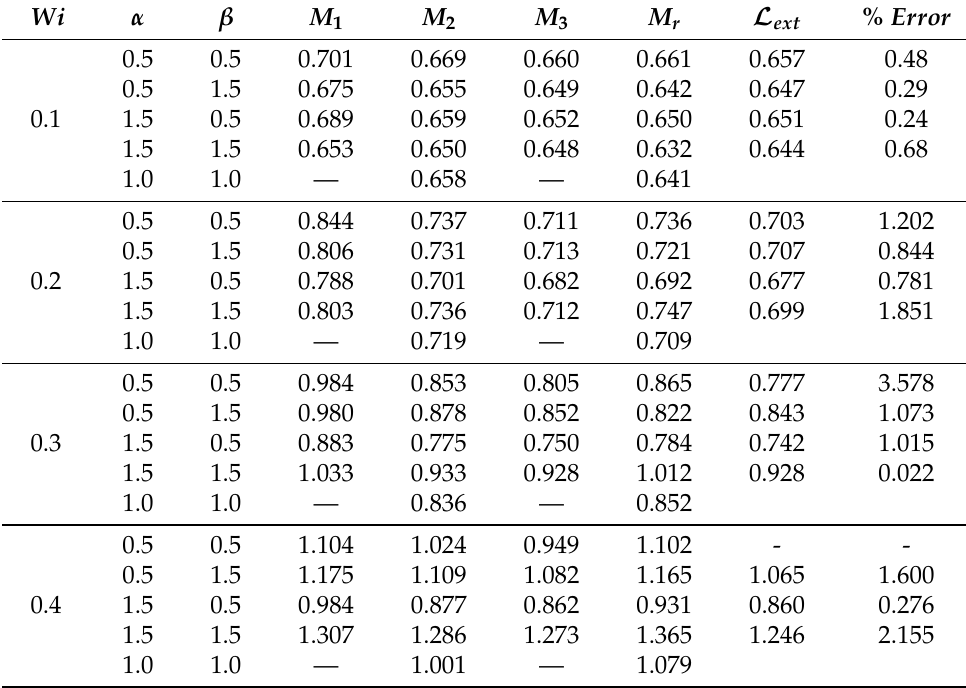
Table 1. Benchmark development length values for the velocity (